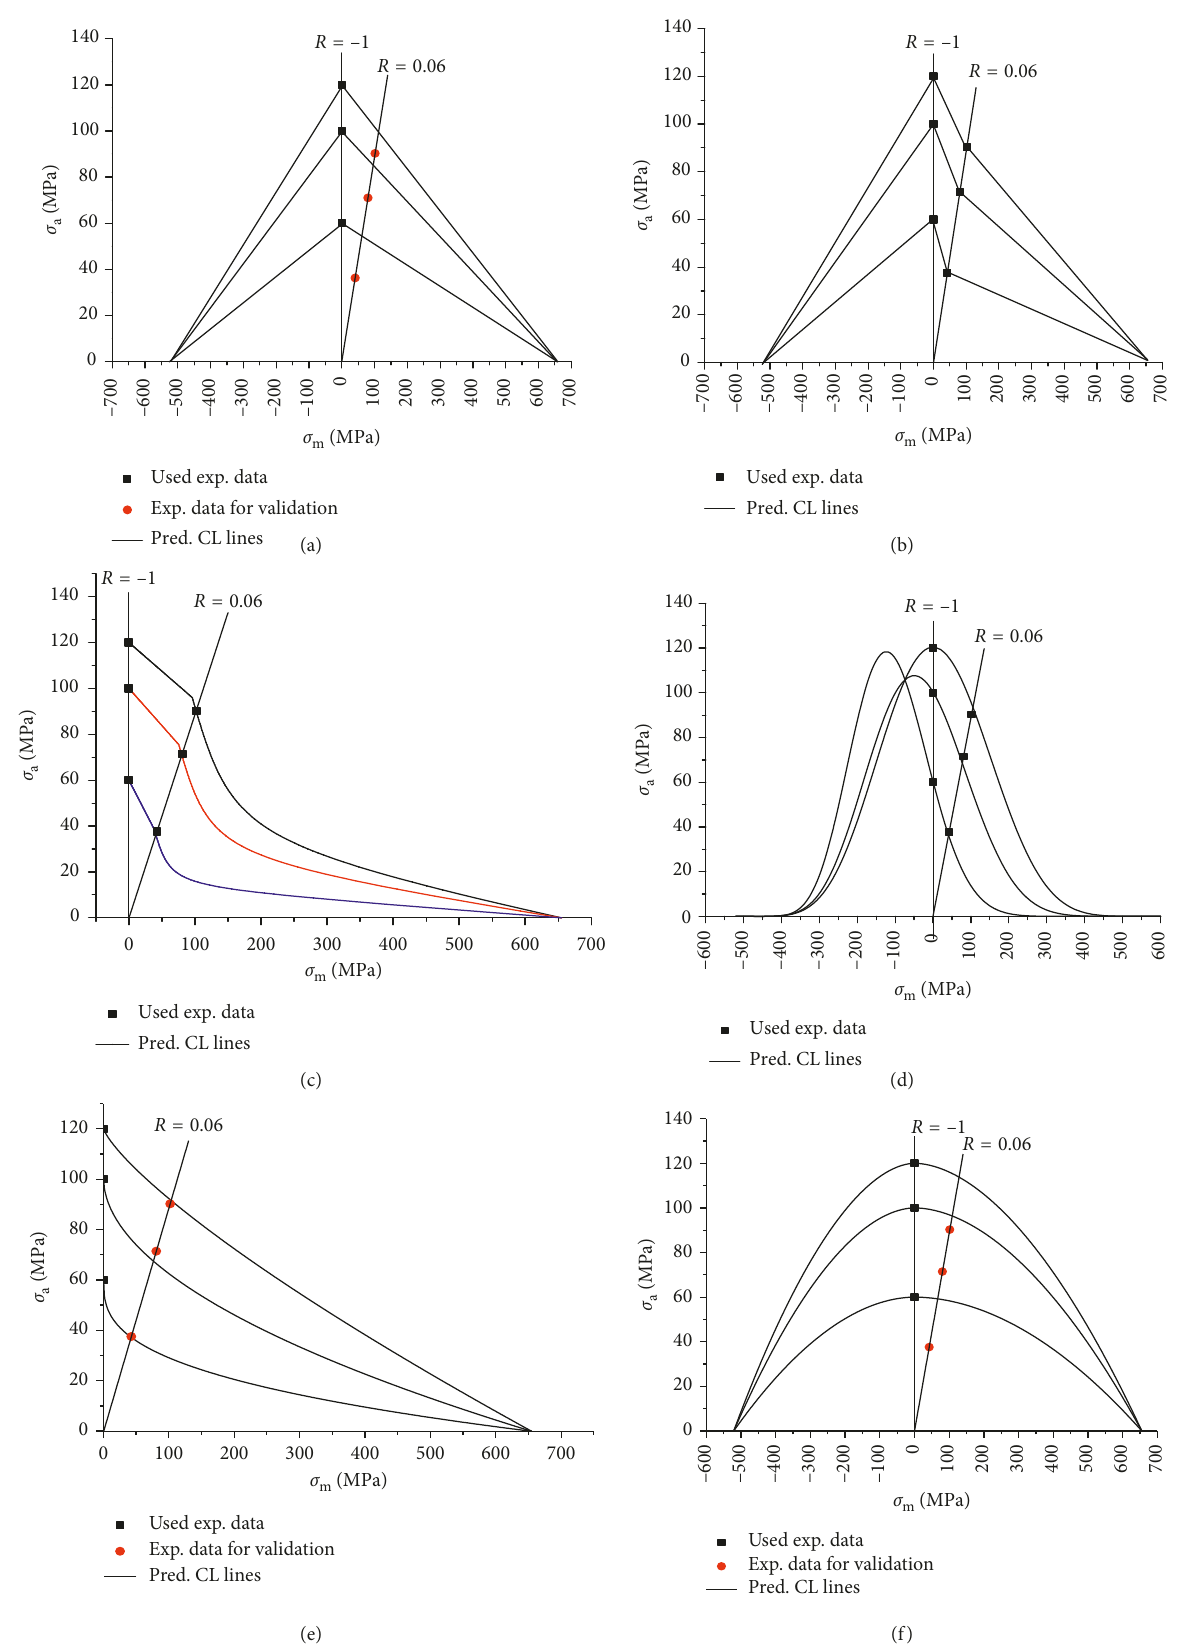
Figure 9: Constant life diagrams for N � 37722 , 76560 , and 555904 for 2/1 laminates: (a) Goodman; (b) piecewise linear; (c) piecewise nonlinear; (d) Bell; (e) Boerstra; (f)